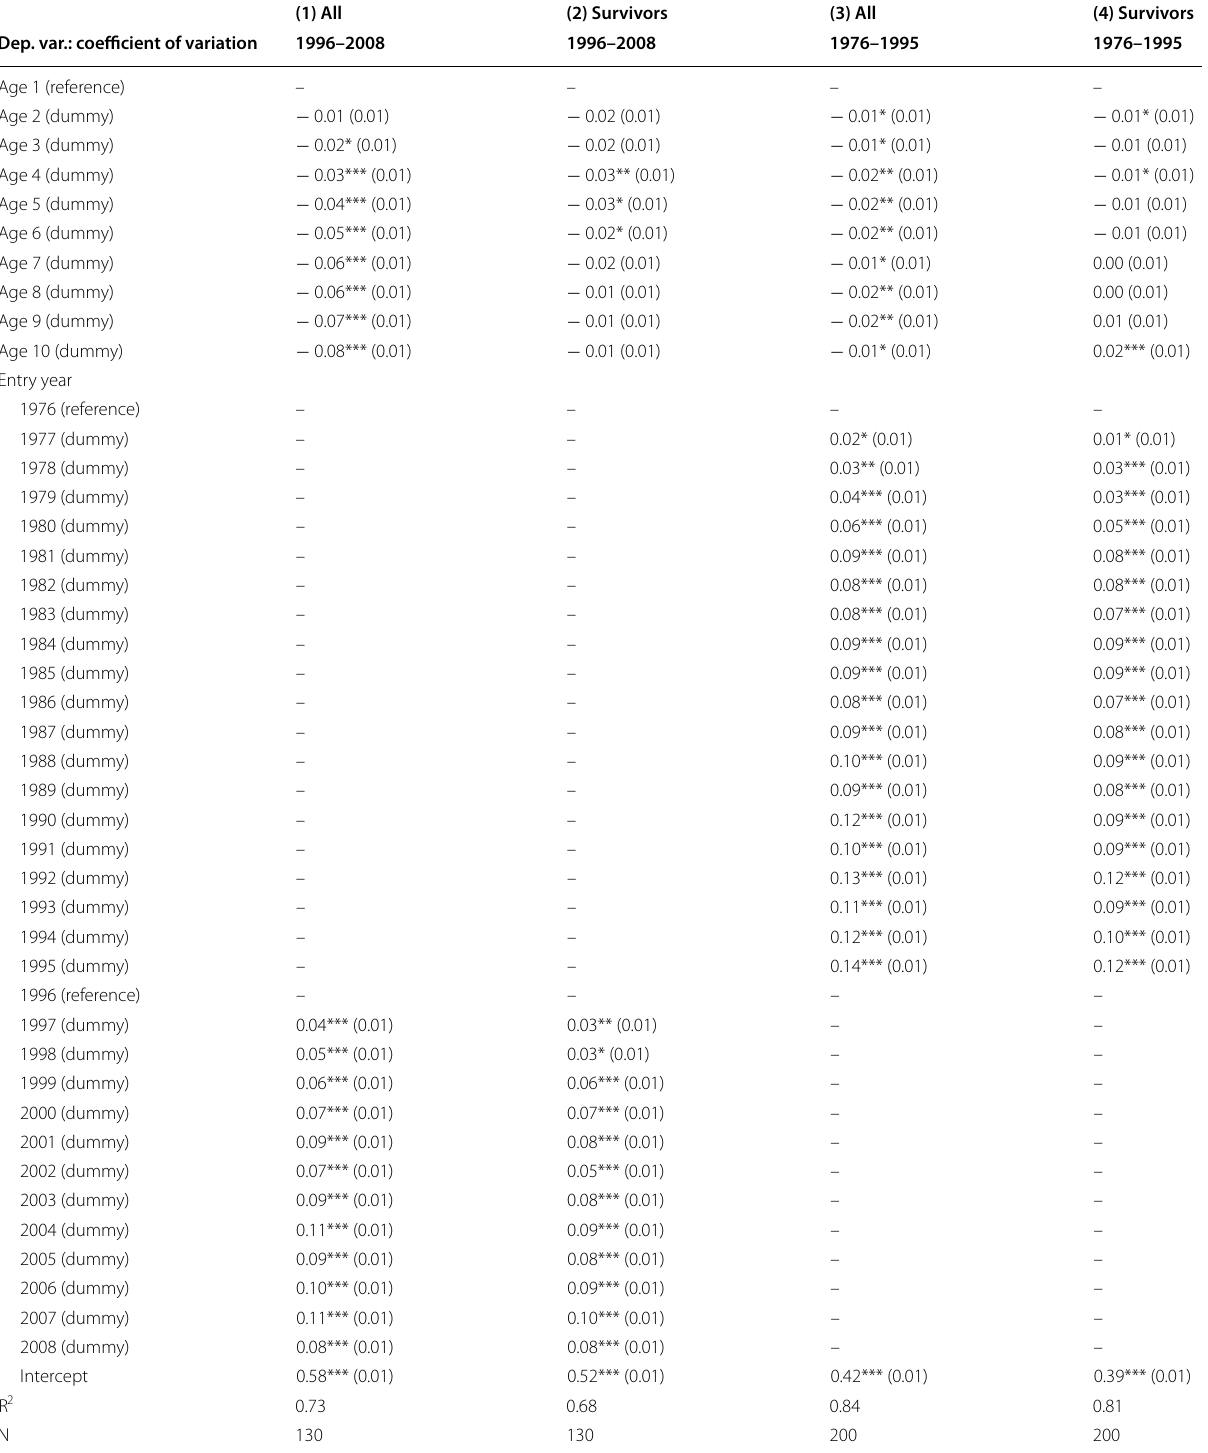
Table 4 Within- and between-cohort wage dispersion in the service